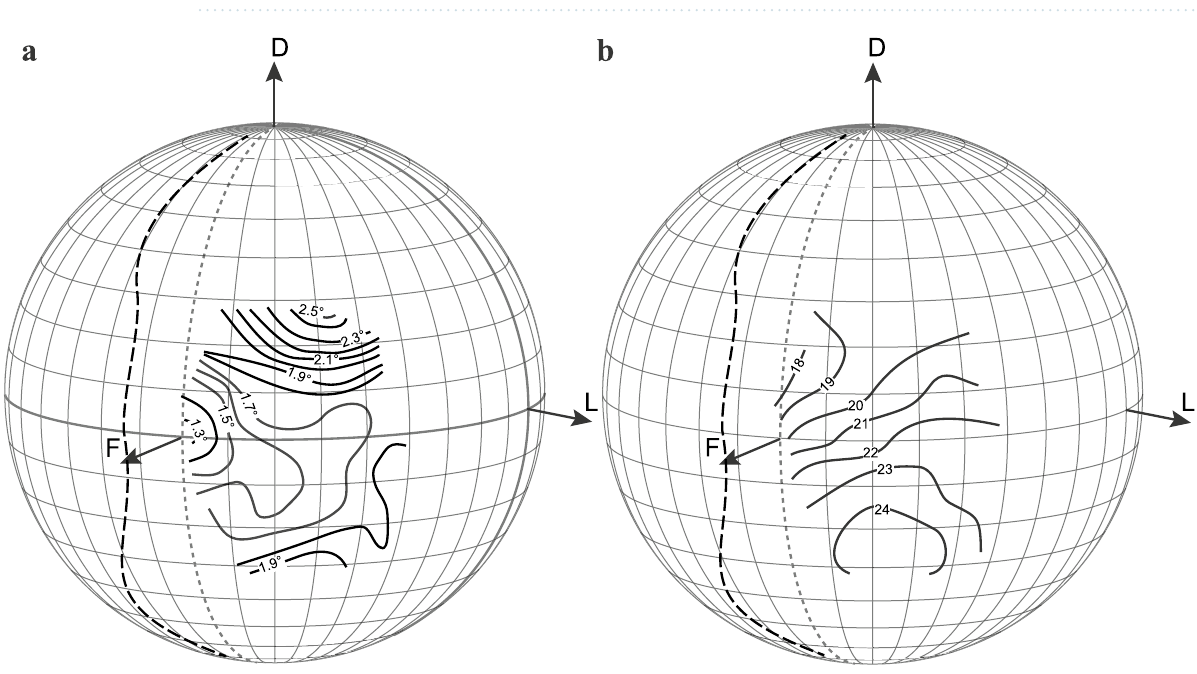
Figure 6. The induced fluorescent pseudopupil is a good tool for estimating the sampling resolution of a compound eye. (a) Projections of the interommatidial angle, Δ φ , (average of horizontal and vertical components) and (b) facet diameter (values in µm) of a single forager honeybee, Apis mellifera . The highest resolution is found in the frontal part of the eye where there is an averaged Δ φ of 1.3°. Note that the location of this minimum value does not coincide with the location in the eye having the largest facet diameter. The boundary of the visual field ( dashed lines ) is reconstructed from 38 . Dotted lines show 0° azimuth. F frontal, D dorsal, L